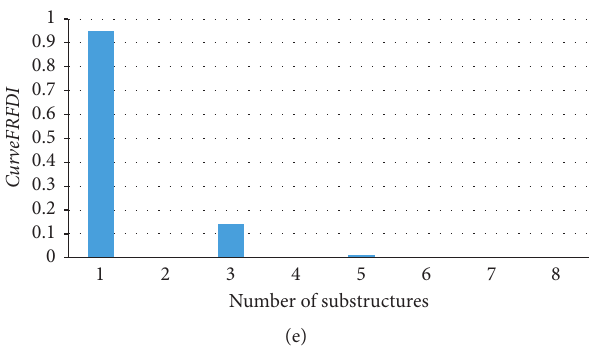
Figure 31: CurveFRFDI values of LVDT-measured data for (a) case Dam50_1F&3F, (b) case Dam100_1F&3F, (c) case Dam200_1F&3F, (d) case Dam500_1F&3F, and (e) case Dam1200_1F&3F.